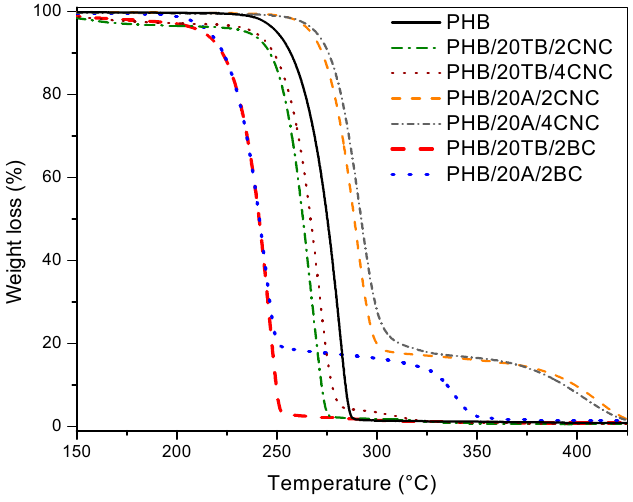
Figure 5. TGA curves of PHB and PHB ternary nanocomposites.